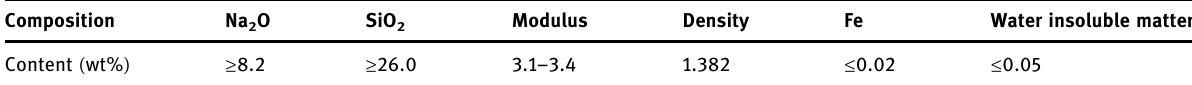
Table 6: Chemical indicators of the sodium silicate Composition